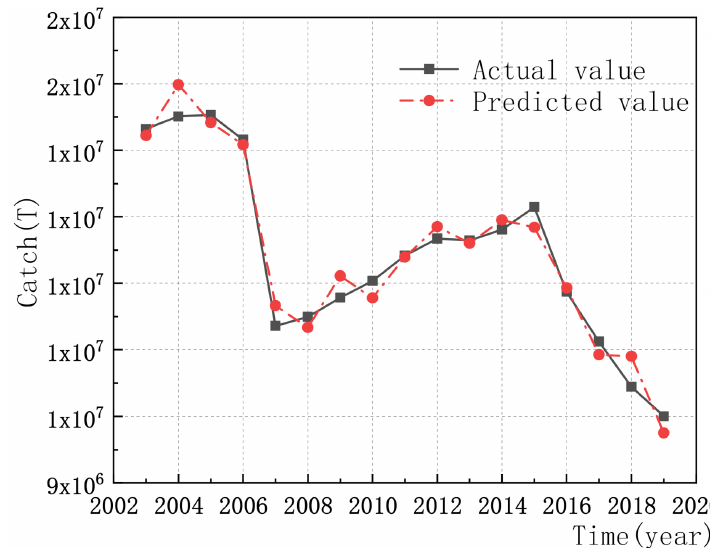
Figure 4. Polynomial